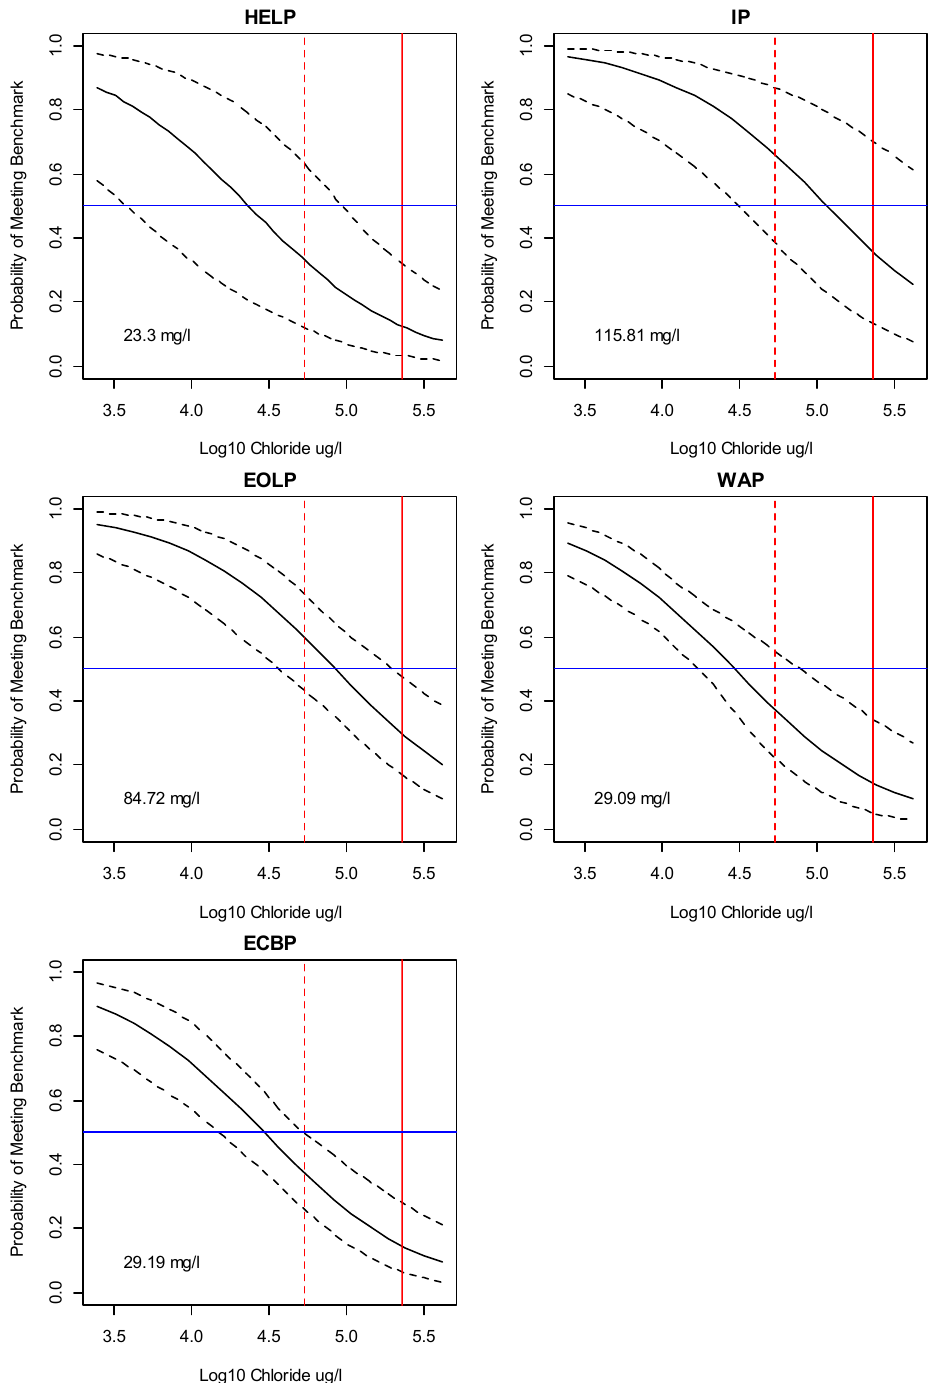
Figure 6. Predicted probabilities and 95% credible intervals of macroinvertebrate communities meeting their ecoregion benchmark as function of chloride concentrations when other model parameters are held at their ecoregion medians. The vertical dashed red line is the HC5 (52 mg/L), the solid vertical red line is the CCC (230 mg/L). The blue horizontal line is drawn at p = 0.5 for reference. Respective median effect levels in standard units are inset as text in the lower left of each plot.